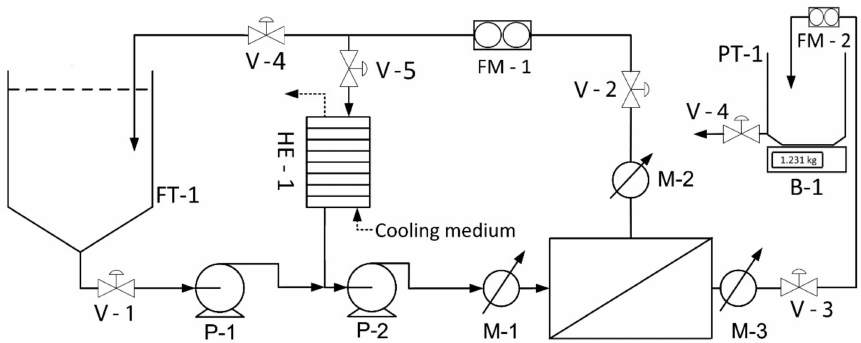
Figure 1. Schematic diagram of the applied membrane separation system for ultrafiltration. FT-1: feed tank; V-1–5: manual diaphragm valves; P-1, 2: centrifugal pumps; HE-1: shell and tube heat exchanger; M-1–3: pressure sensors; PT-1: permeate tank; FM-1, 2: electromagnetic flowmeters;